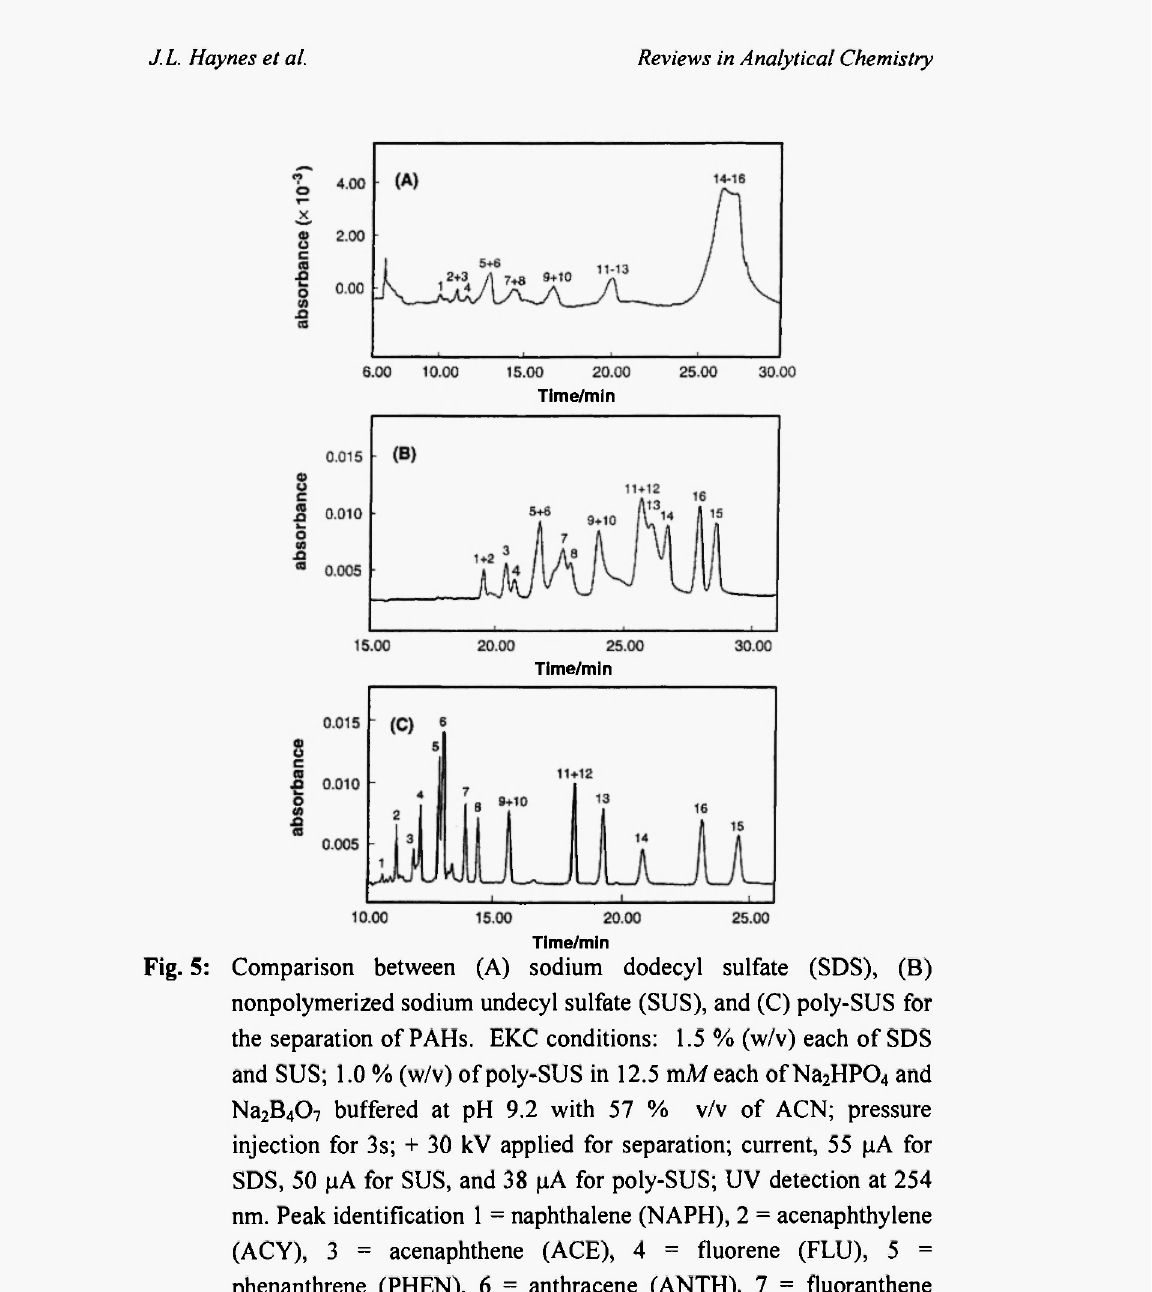
Fig. 5: Comparison between (A) sodium dodecyl sulfate (SDS), (B) nonpolymerized sodium undecyl sulfate (SUS), and (C) poly-SUS for the separation of ΡAHs. EKC conditions: 1.5 % (w/v) each of SDS and SUS; 1.0 % (w/v) of poly-SUS in 12.5 mMeach ofNa 2 HP0 4 and Na 2 B 4 0 7 buffered at pH 9.2 with 57 % v/v of ACN; pressure injection for 3s; + 30 kV applied for separation; current, 55 μΑ for SDS, 50 μΑ for SUS, and 38 μΑ for poly-SUS; UV detection at 254 nm. Peak identification 1 = naphthalene (NAPH), 2 = acenaphthylene (ACY), 3 = acenaphthene (ACE), 4 = fluorene (FLU), 5 = phenanthrene (PHEN), 6 = anthracene (ANTH), 7 = fluoranthene (FLT), 8 = pyrene (PYR), 9 = benz[a]anthracene (BaA), 10 = chrysene (CHRY), 11 = benzo[b]fluoranthene (BbF), 12 = benzo[k]fluoranthene (BkF), 13 = benzo[a]pyrene (BaP), 14 = dibenzo[ah]anthracene (DIBAhA), 15 = benzo[gh]perylene (BghiP), and 16 = indeno[123cd]pyrene (INPY). From 741/ with permission.